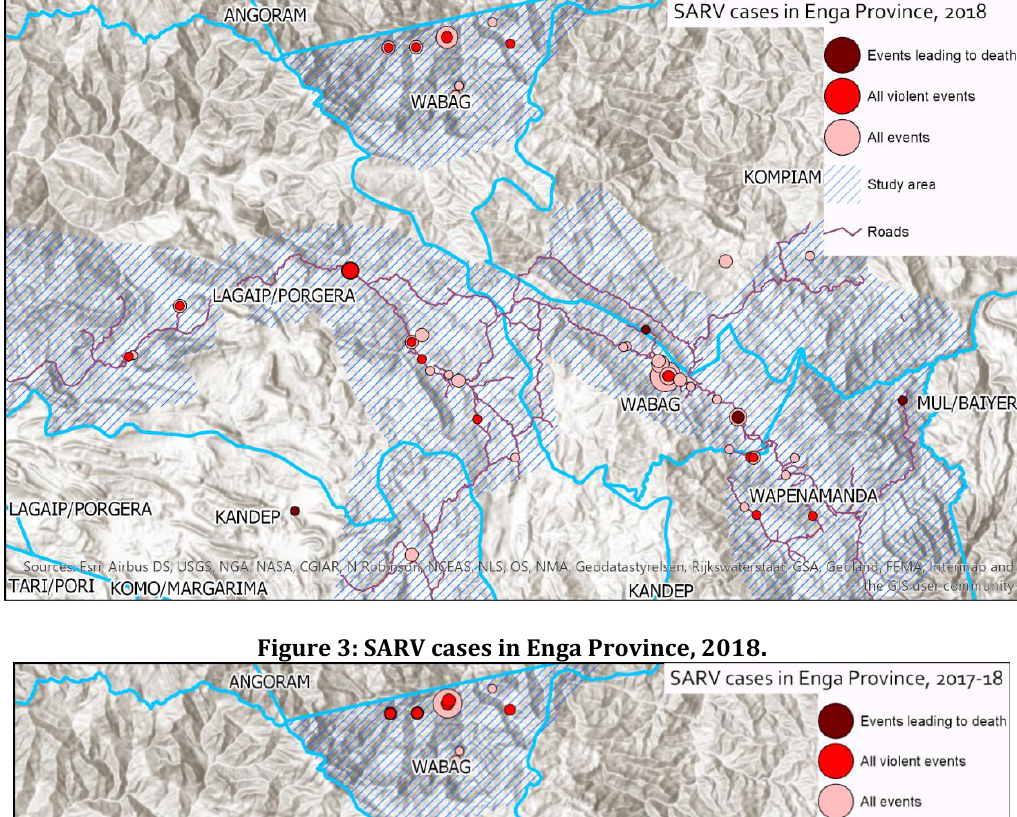
Figure 3: SARV cases in Enga Province, 2018 .